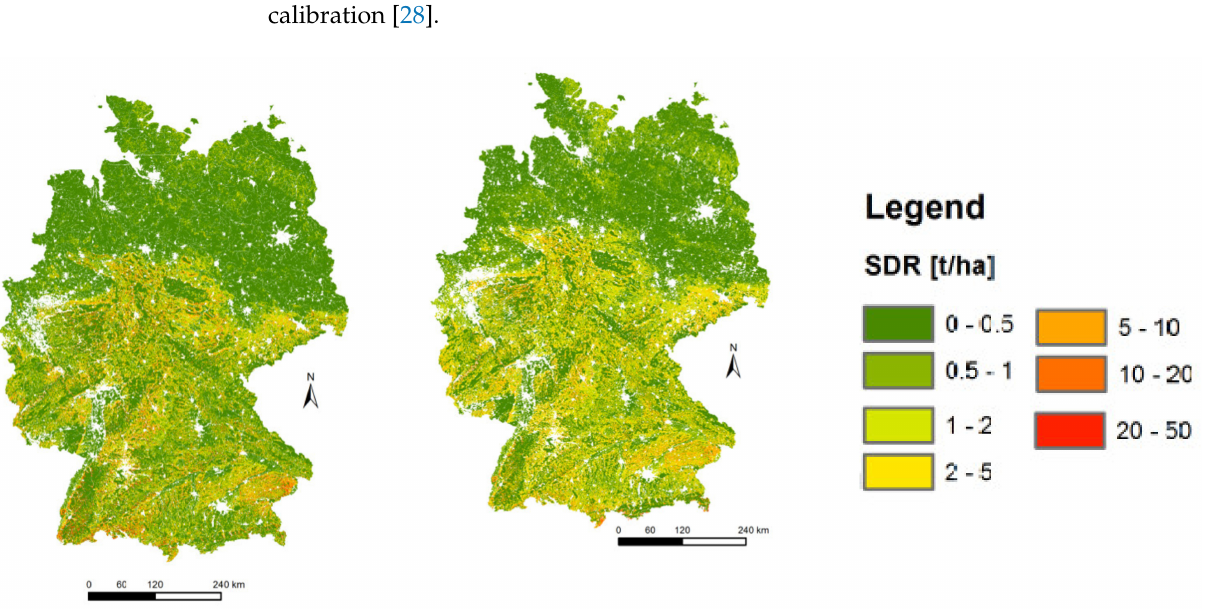
Figure 2. Output of the InVEST Sediment Delivery Ratio (SDR) model ( left ) and the Joint Research Center (JRC) map of soil loss due to water erosion [t/ha] ( right ), a similar pattern was observed in